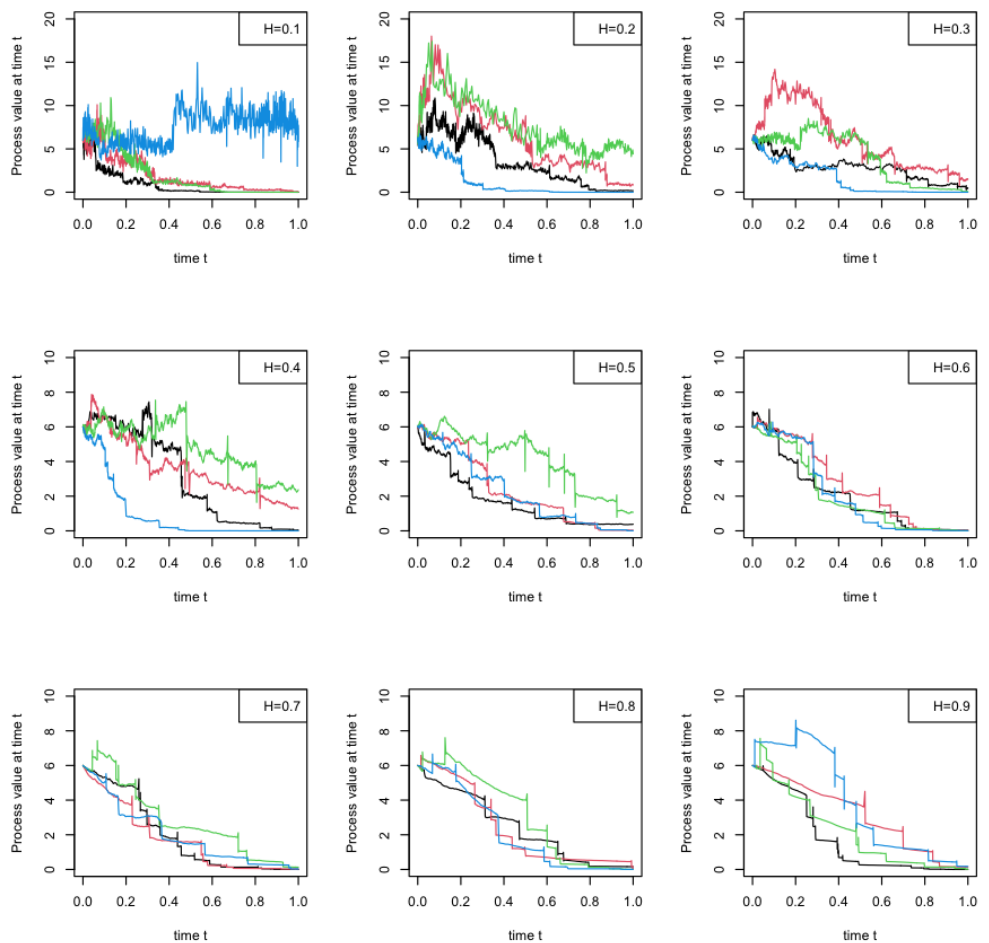
( 1,0.1,10, ( 0.1,0.01 ) ,6, H ) over [ 0,1 ] for H M −